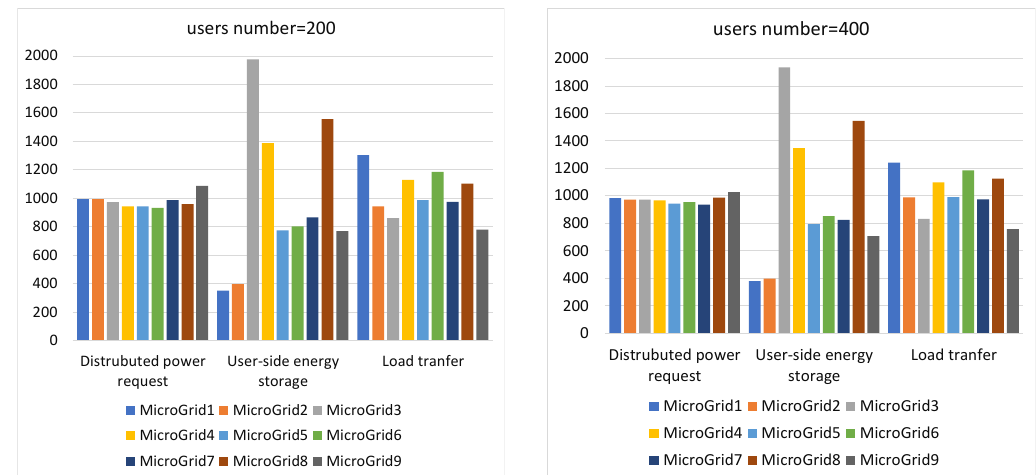
Figure 8. Price Decided by Each Micro-grid using different methods.